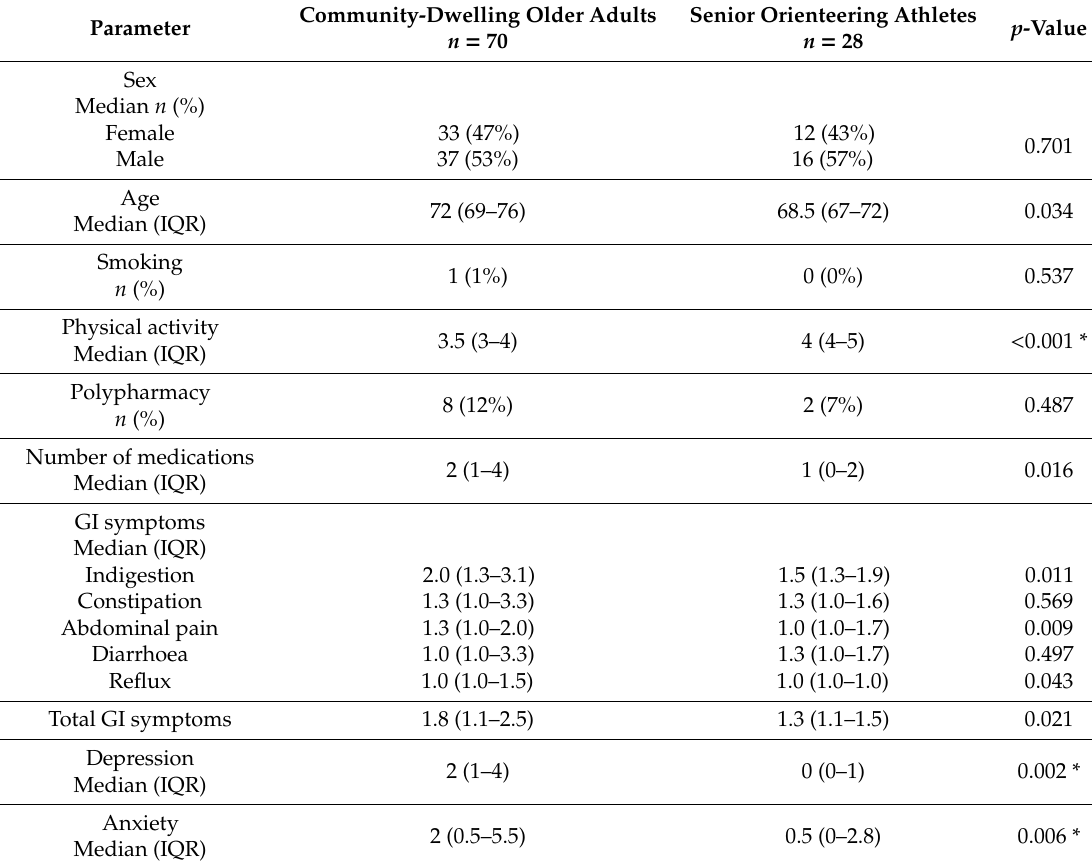
Table 2. Participant